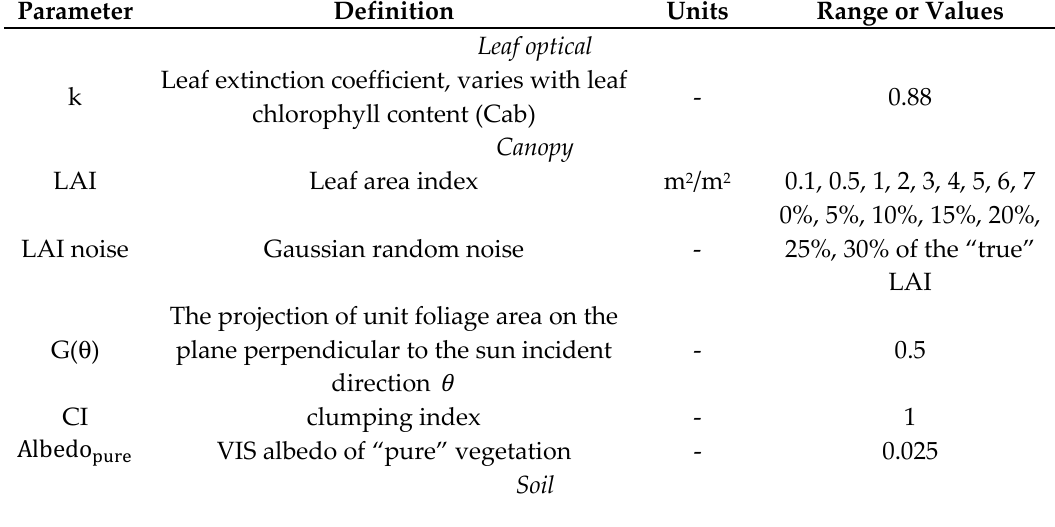
Table 4. The main inputs of the NSM model and EBR method in the validation experiment using simulations by the PROSAIL model. A Gaussian random noise with a relative intensity of 0% to 30% was added to the canopy LAI values to investigate the sensitivity of the EBR